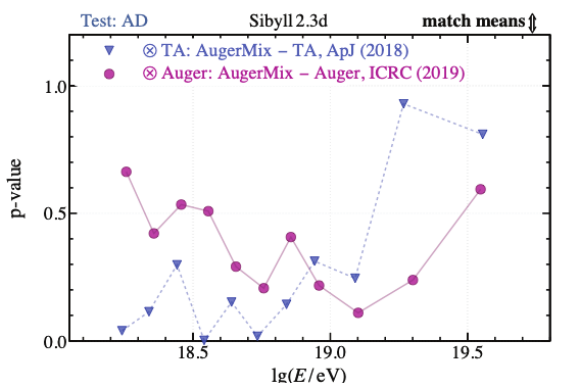
Figure 4. p -values from Anderson-Darling comparisons after removing di ff erences in mean between TA and Auger ⊗ TA X max distributions and between Auger and the AugerMix distributions. p -values should be roughly uniformly distributed between 0 and 1 for distributions drawn from the same underlying distribution. The very low p -values in the TA-Auger ⊗ TA comparison at 18.55 and 18.75 are indicative of a poor match.